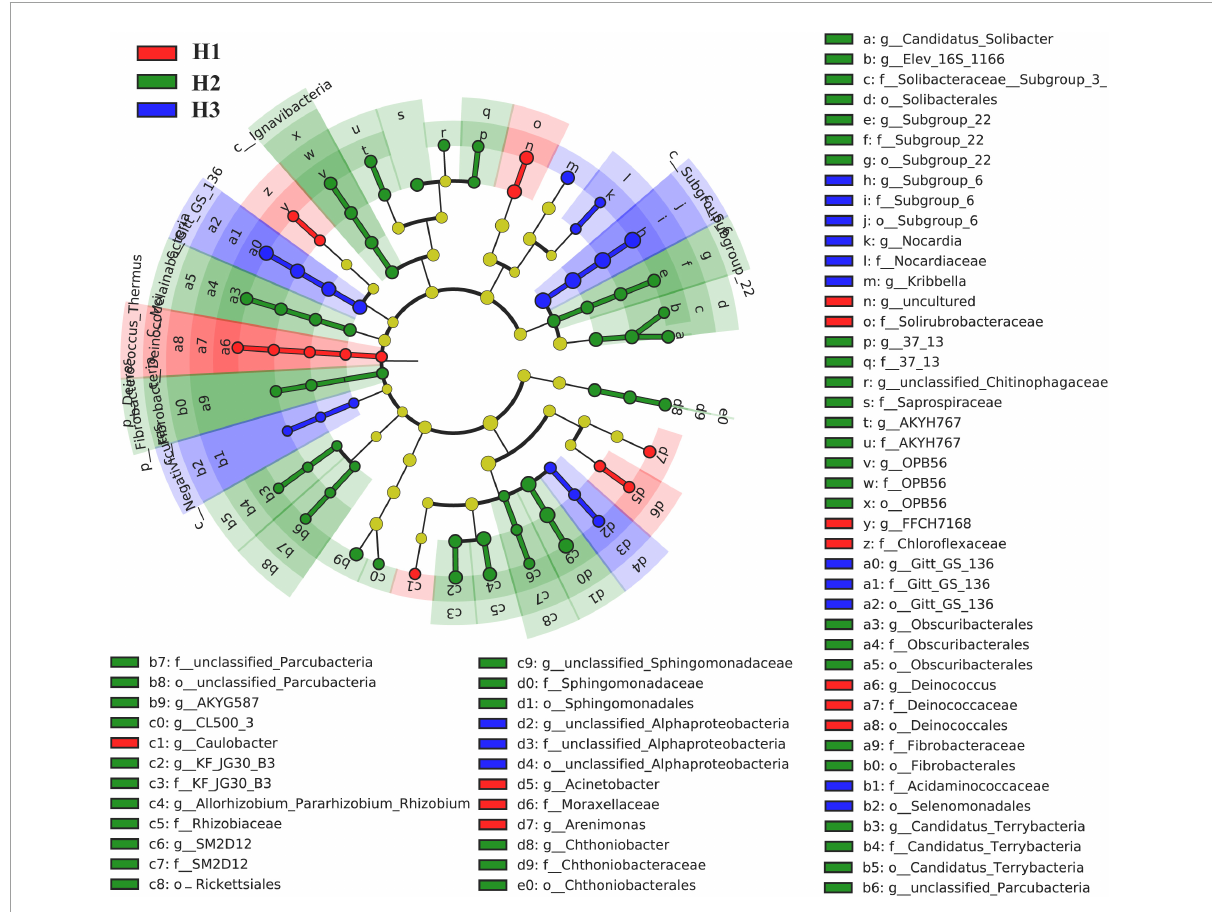
FIGURE3 Linear discriminant effect size analysis (LEfSe) on the rhizobacteria biomarkers of poplar genotypes.